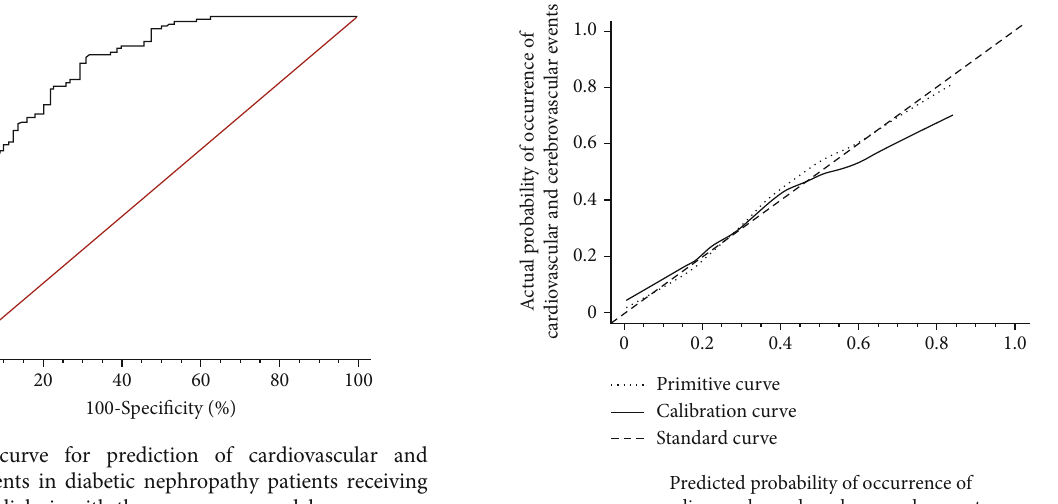
Figure 3: Calibration curve graph for prediction with the nomogram